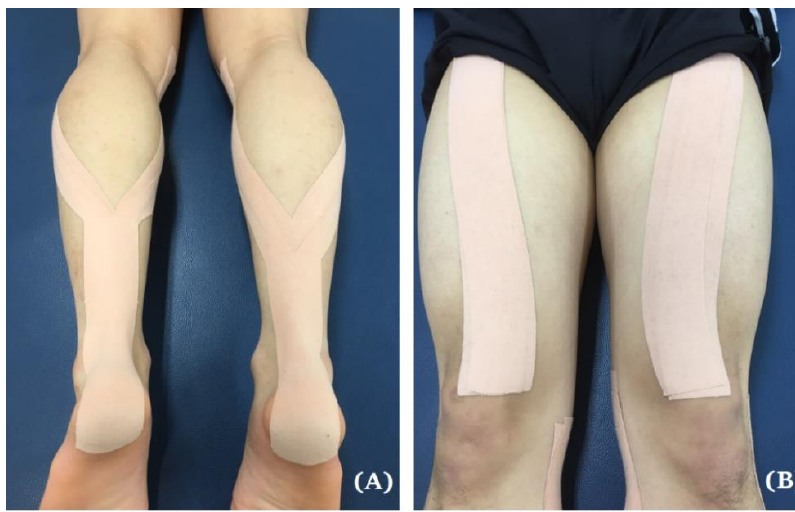
Figure 2. ( A ) Kinesio taping with double-taped application to the calf muscle; ( B ) Kinesio taping with double-taped application to the rectus femoris.